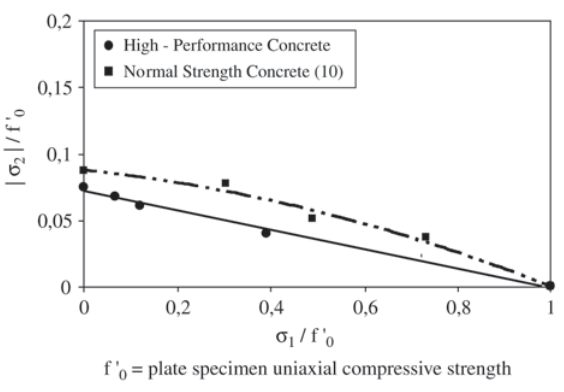
Figure 2. Strength Envelope of Concrete under Biaxial Tension- Compression